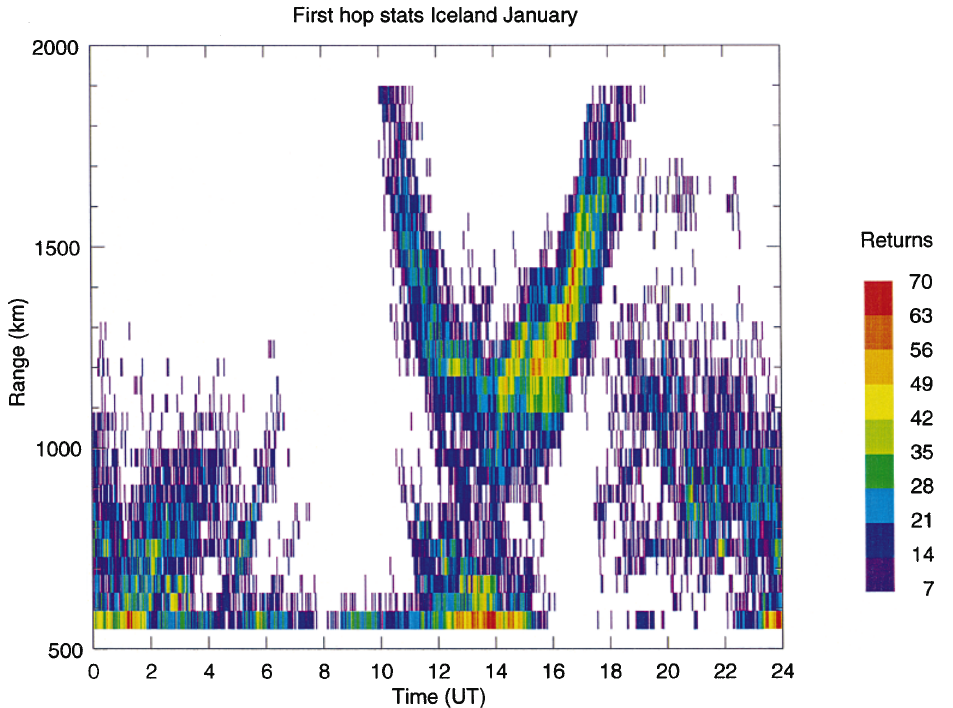
Fig. 4. First skip range statistics for January, 1997 combining all the beams from the Iceland CUTLASS radar with data from the first 10 range